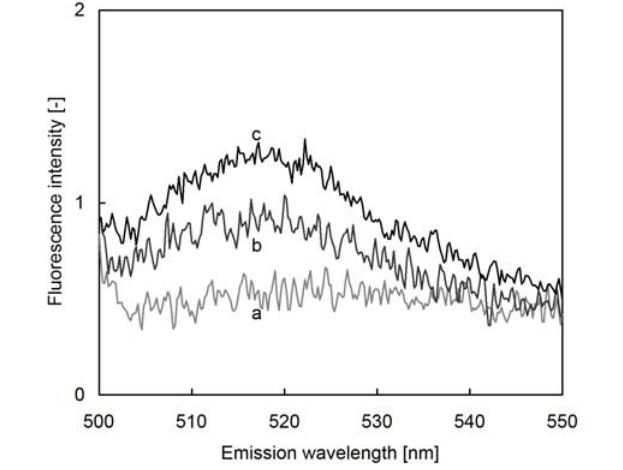
Figure 2. Fluorescence spectrum of immobilized FITC-Protein A. Line 'a' is spectrum of bovine plasma without FITC-Protein A immobilized glass, Line 'b' is spectrum of immobilized FITC-Protein A immersed in bovine plasma, Line 'c' is enhanced fluorescence spectrum at 78  g/mL IgG in bovine